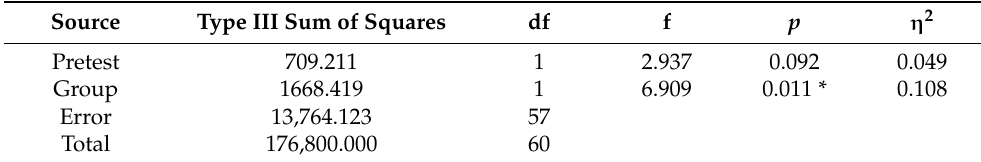
Table 4. ANCOVA results on learning achievement for both